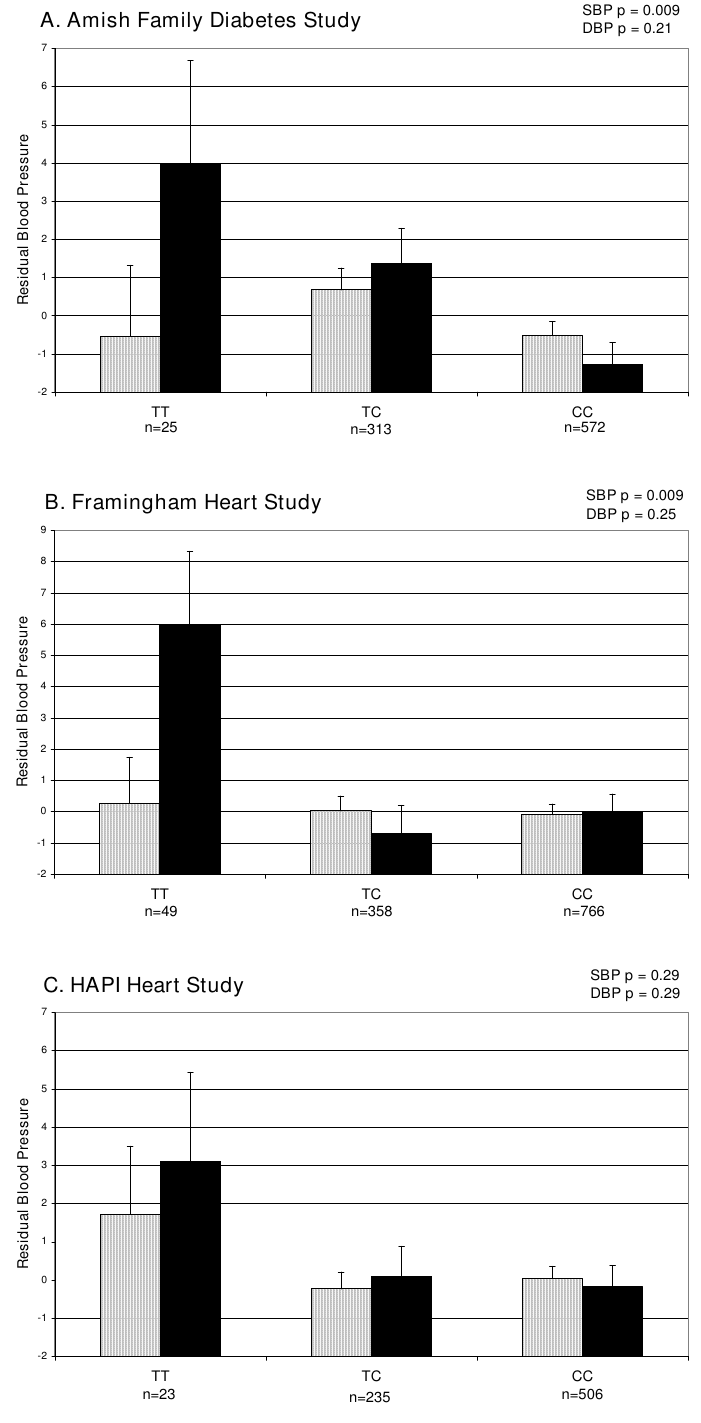
Figure 3 Mean of age and sex adjusted residual blood pressure by rs2099489 genotype for the A. Amish Family Diabetes Study; B. the Framingham Heart Study; and C. the Heredity And Phenotype Intervention (HAPI) Heart Study. SBP residual in solid bars, DBP residual in hatched bars. Standard error is represented by vertical